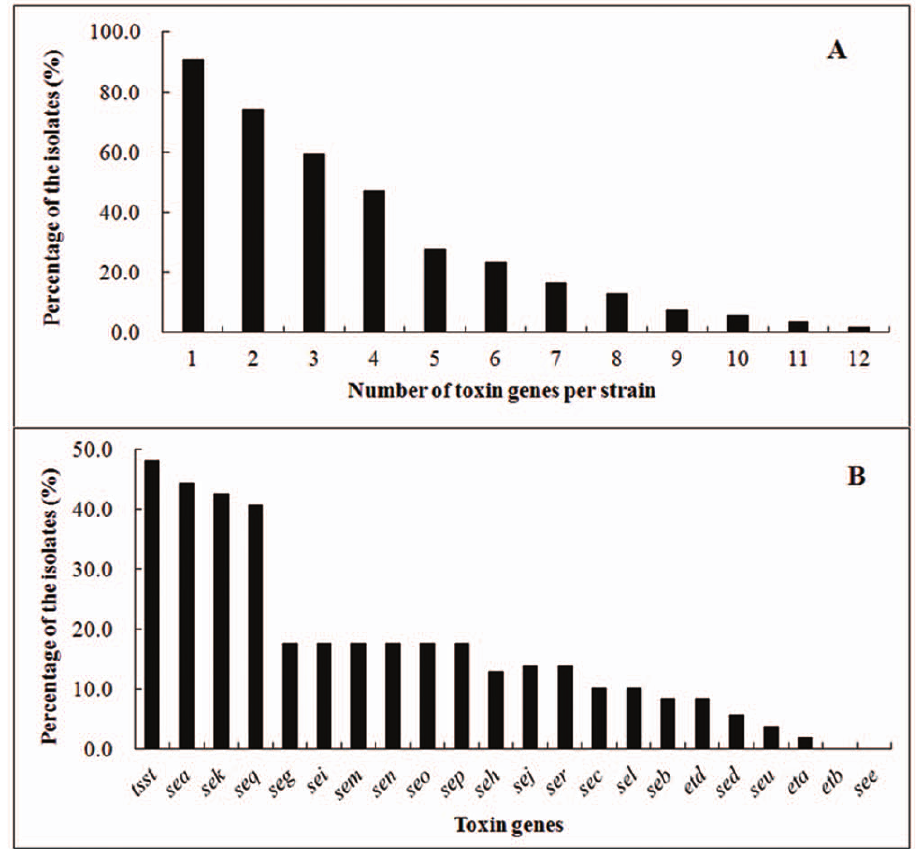
Figure 1. Prevalence of 22 toxin genes in 108 S.aureus clinical isolates. (A) The percentage of isolates containing different numbers of (1 to 12) toxin genes per strain. (B) The occurrence of each toxin gene in the isolates.